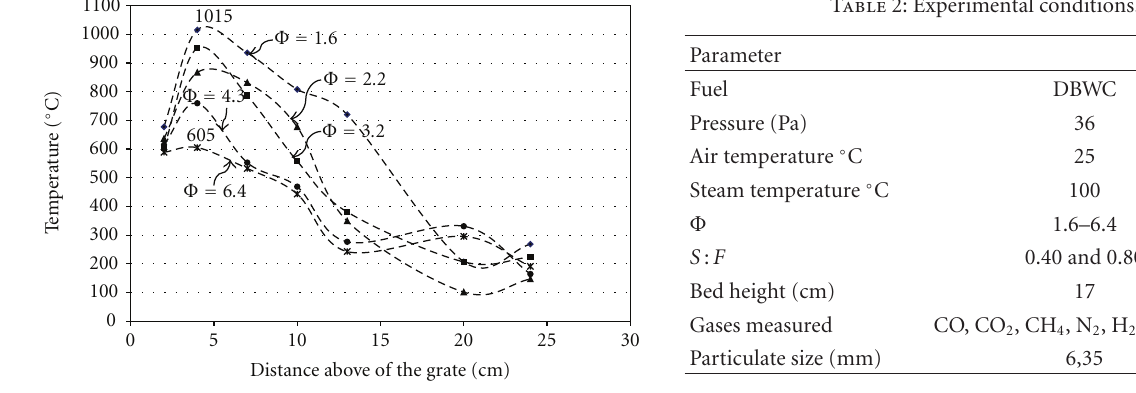
Figure 3: Temperature profile along the gasifier axis for gasification of pure, DB at S : F = 0 . 4, adapted from [11], also available in [10].